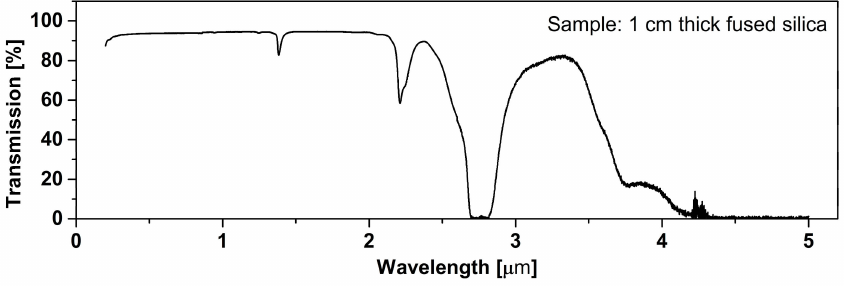
Figure 9. Transmission of 1-cm-thick fused silica glass in function of